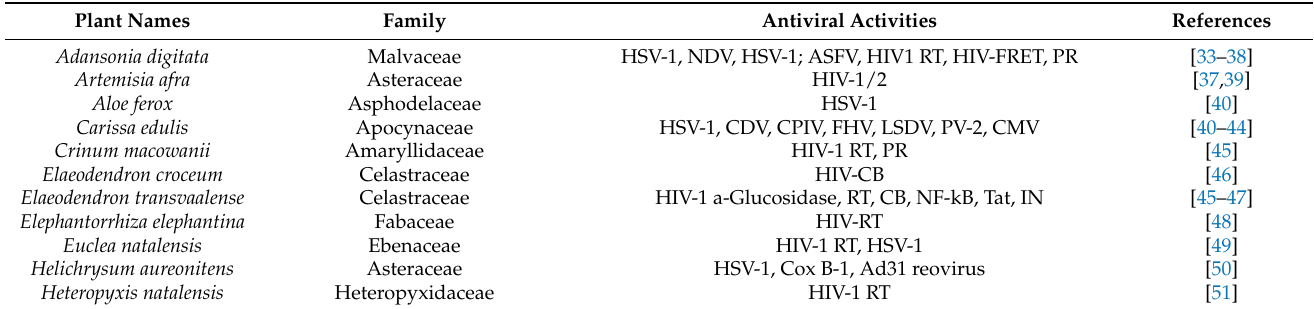
Table 1. Plants with reported pharmacological anti-viral activity, their family names and antiviral activities. Plant Names Family Antiviral